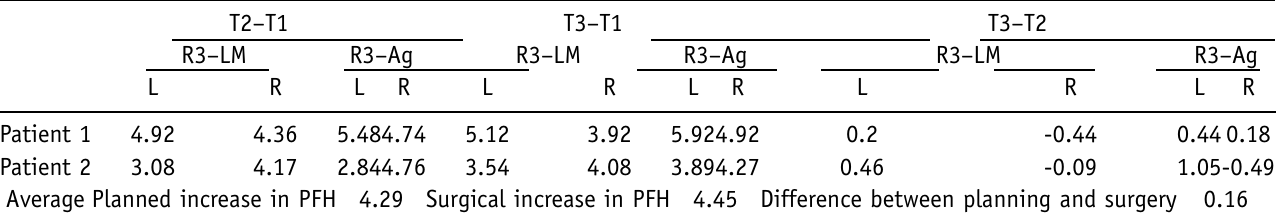
Table III. Differences between given measures (in